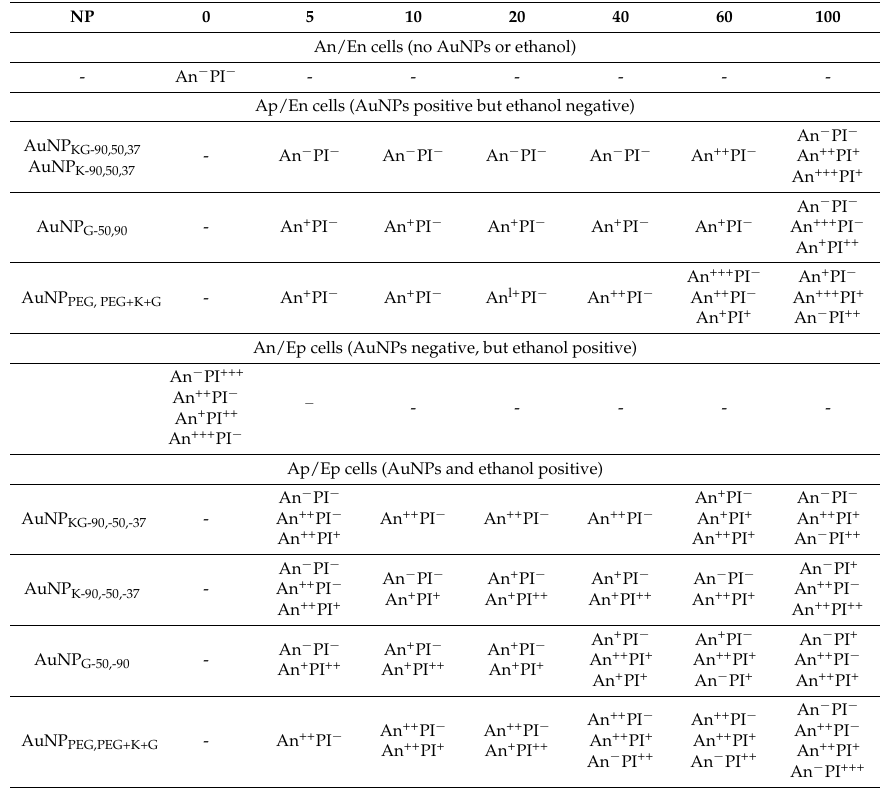
Table 2. Effects of AuNP dose on SH-SY5Y cell phenotype.